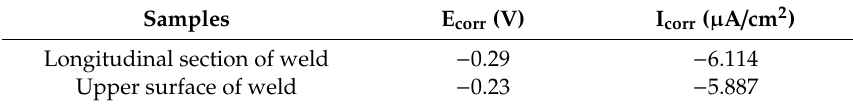
Table 4. Corrosion parameters of the longitudinal section and upper surface of the weld.